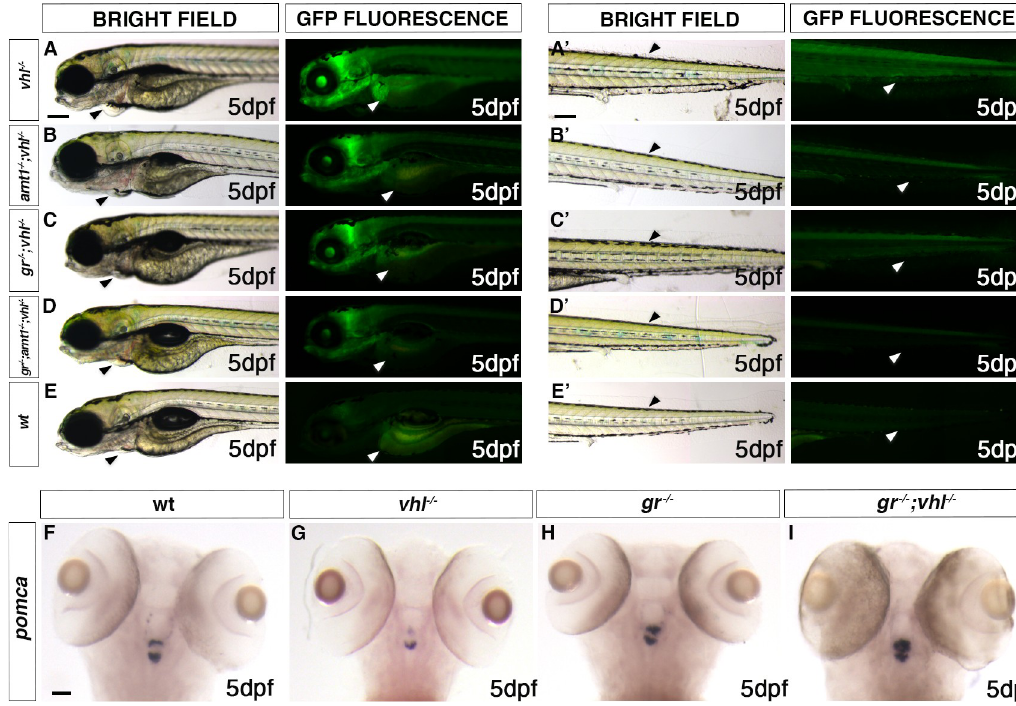
Fig 4. gr loss of function effect is stronger when HIF-signalling is moderately upregulated. A-E. Representative picture of the main differences between vhl -/- , arnt1 -/- ;vhl -/- , gr -/- ;vhl -/- and triple gr -/- ;arnt1 -/- ;vhl -/- larvae at 5 dpf. Among the 488 phd3 : eGFP expressing larvae analysed, 7 larvae were characterized by the absence of pericardial oedema (black arrowheads, left), no ectopic extra vasculature at the level of the tail (black arrowheads, right), no visible phd3:eGFP HIF reporter in the liver (white arrowheads, left) and even more reduced levels of this marker in the head and in the rest of the body (white arrowheads, right). Genotypic analysis allowed to confirm the presence of a genotype-phenotype correlation in 5 out 7 samples and to prove that they were triple mutants. Fluorescence, exposure = 2 seconds. Scale bar 200 μ m. F-I. Representative pictures of WISH performed on gr +/- ; vhl +/- incross derived larvae, at 5 dpf, using pomca as probe. Of note, gr -/- ;vhl -/- showed upregulated pomca expression (20/20 larvae), as observed in gr -/- ( 20/20 larvae) ; vhl mutants showed downregulated pomca expression (20/20 larvae), whereas wildtypes showed normal pomca expression (19/20). Chi-square test ( ���� P < 0.0001). Scale bar 50 μ